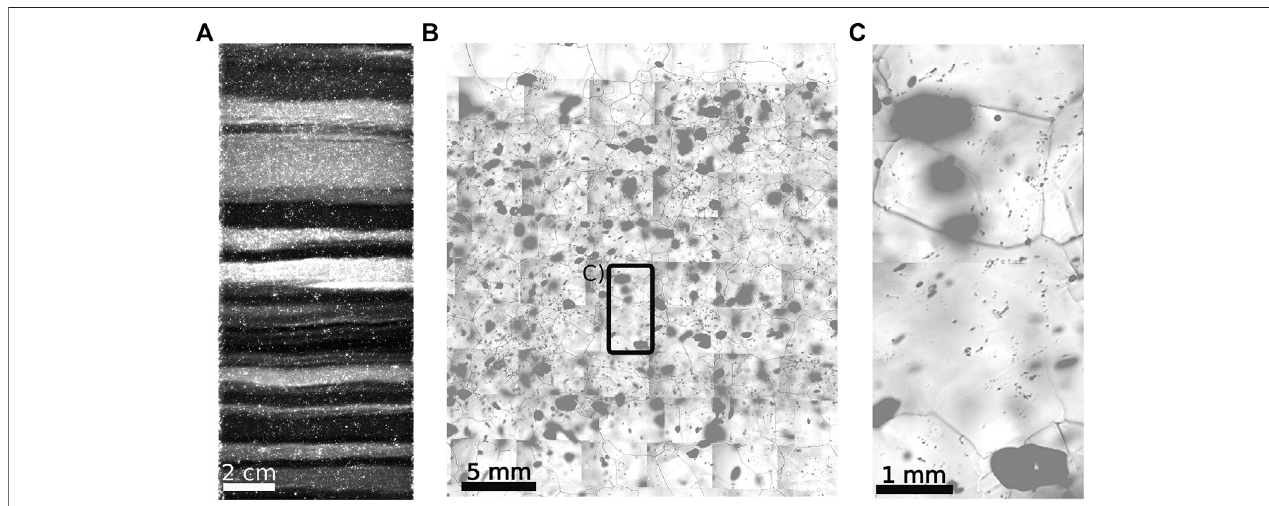
FIGURE 1 | Cloudy bands - layers with high impurity concentrations and small grain size (Stoll and Weikusat, 2020). (A) Visual stratigraphy image from the EGRIP icecore(depth:1,917 m),dark- fi eldmicroscopyrevealsbrightlayerswithhighimpurityconcentrations. (B) Detailedviewofthethickestcloudybandfrom (A) .Smalldark dots are micro-inclusions, large black objects are bubbles, dark lines are grain boundary contours on the surface of the sample and bright objects are preserved hydrates. (C) Detailed viewoftheareaindicatedin (B) .CombinedfromFigure3fromSvensson et al.,(2005),Figures 2and4fromKipfstuhlet al.,(2006),Figures 1 and 2 from Faria et al., (2010), and Figure 3b from Eichler et al., (2017).